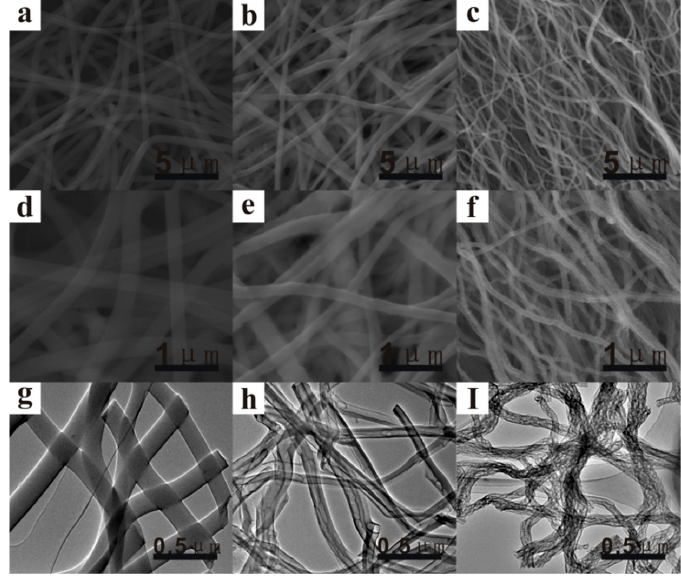
Figure 3. SEM and TEM measurements (images) of PVP, CNF and PCNF nanofibers: ( a , d , g ) PVP nanofibers; ( b , e , h ) CNF nanofibers; ( c , f , i ) PCNF nanofibers.